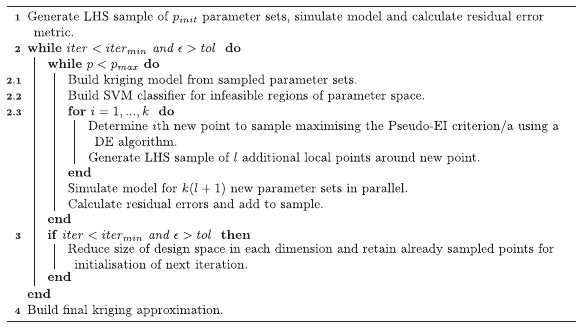
Algorithm 1 Kriging-based optimisation work fl ow.